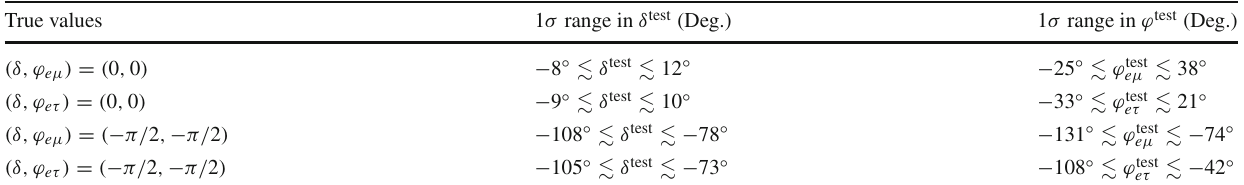
Table1 Thetypical1 σ allowedrangesaroundthetruevaluesoftheCP phases δ and ϕ e β (where β can be μ or τ ). Here, we assume the strength of the true LIV parameters | a e μ | and | a e τ | to be 5 × 10 − 24 GeV, and we True values 1 σ range in δ test (Deg.)